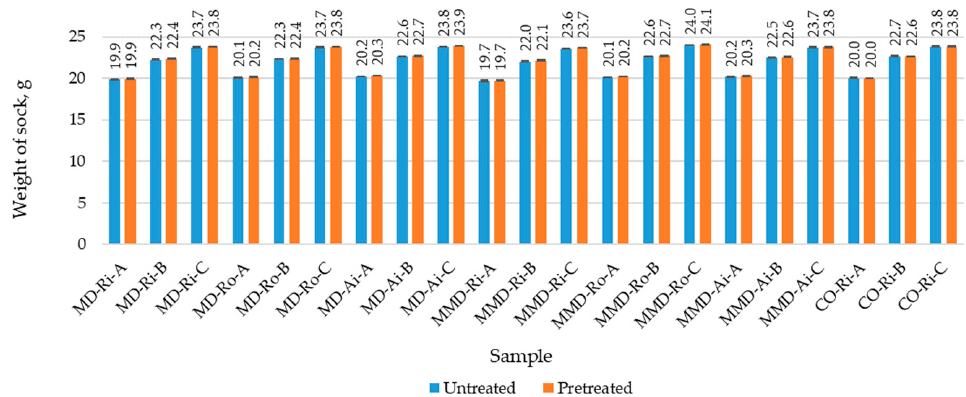
Figure 8. Weight of the untreated and pretreated sock samples determined before and after five repeated washing and drying cycles (where MD—modal fibers, MMD—micro modal fibers, CO— cotton fibers; Ri—ring spun yarn, Ro—rotor spun yarn, Ai—air-jet spun yarn; A, B, C—sock group).